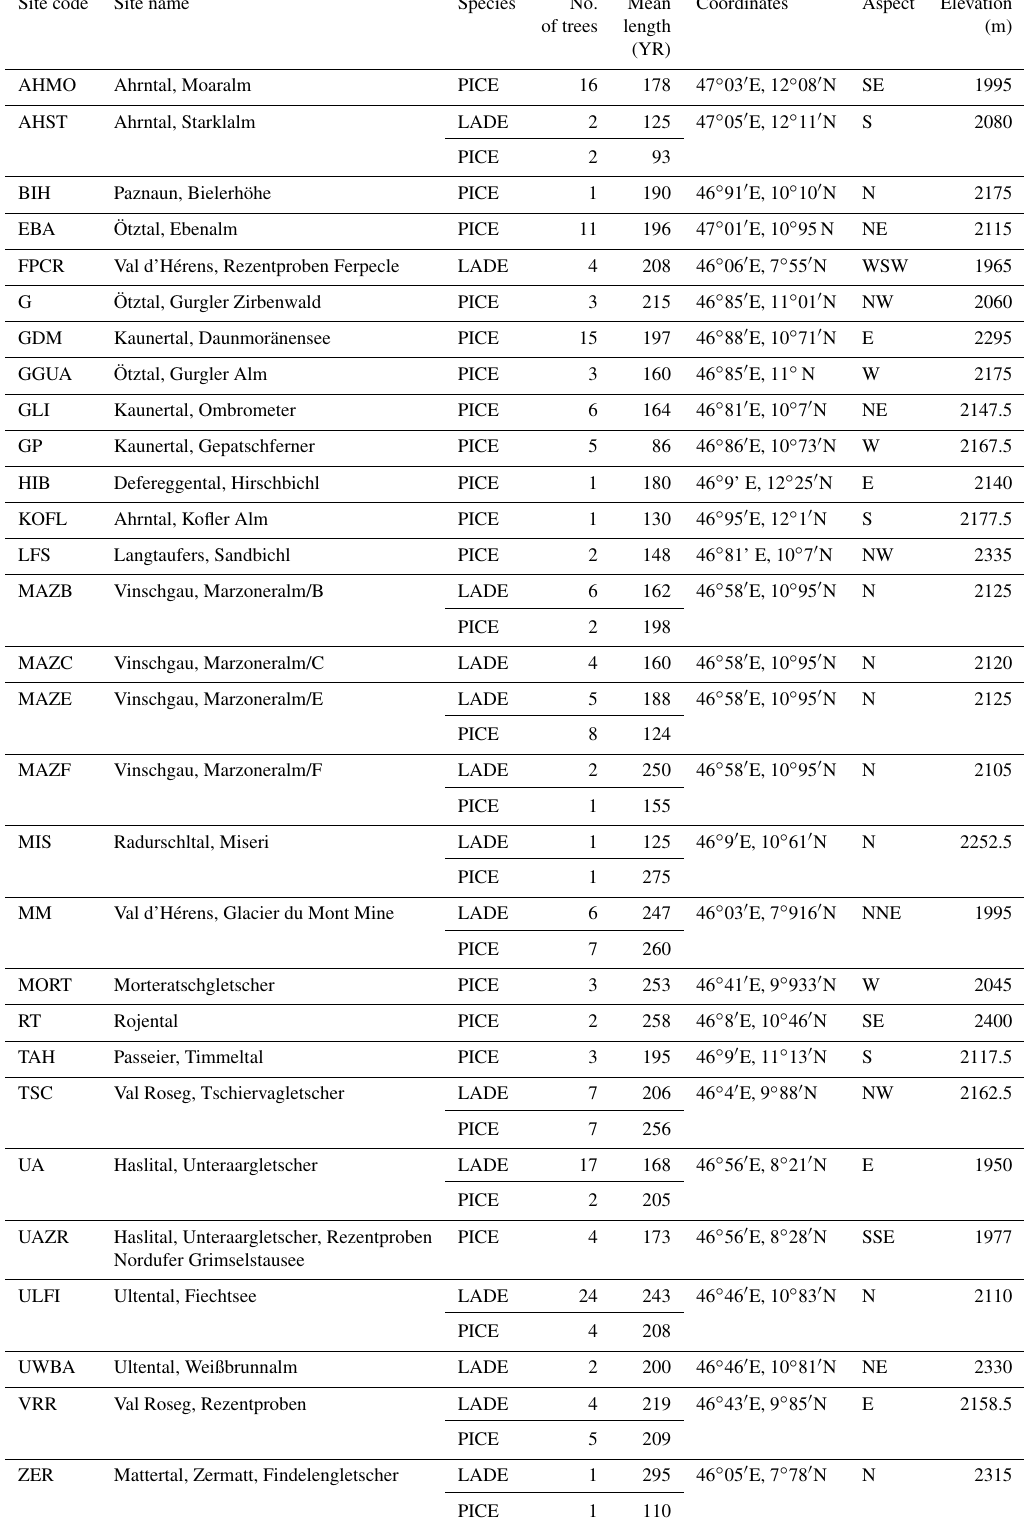
Table 1. Characteristics of the sampling site and of the trees: 11 sites contain both larch and cembran pine samples, 2 sites contain only larch (LADE) specimens, and the remaining sites contain only cembran pine